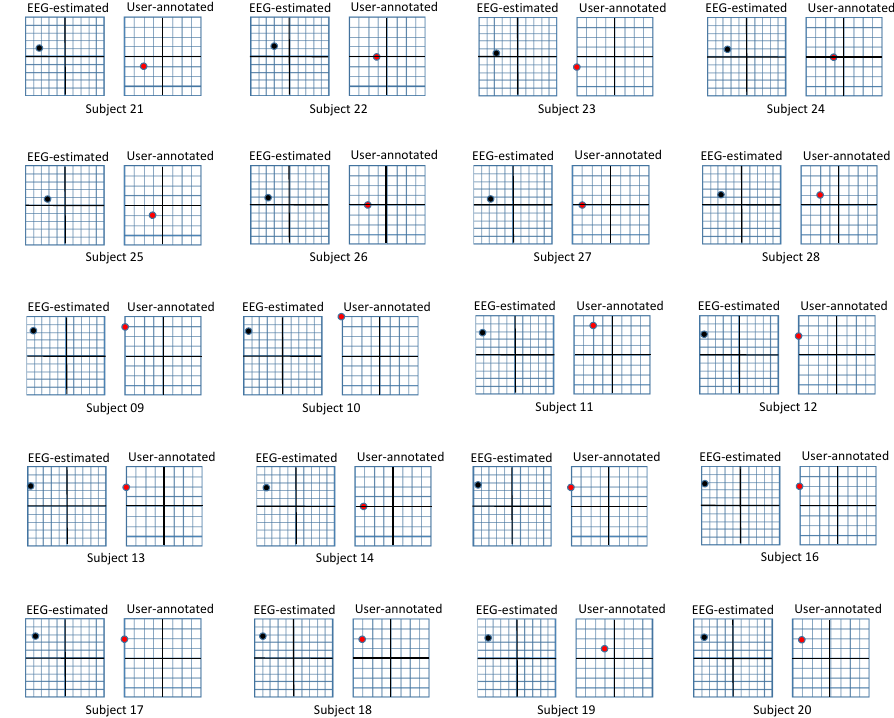
Figure 9. Results from illustrated surgical images. Subjects 21 ∼ 40 participated in the experiment for illustrated surgical images. The left box, which corresponds to EEG-based recognition has a range of ( − 1,1 ) × ( − 1,1 ) , while the right box corresponding to user-annotated emotion has a range of ( 1,9 ) × ( 1,9 ) . The x-axis of each box represents valence and the y-axis represents arousal.